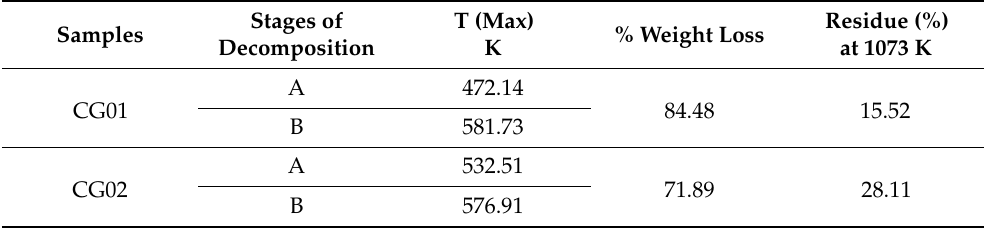
Table 2. The thermal degradation temperature, % weight loss, and residual content of CG01 and CG02 hydrogels.